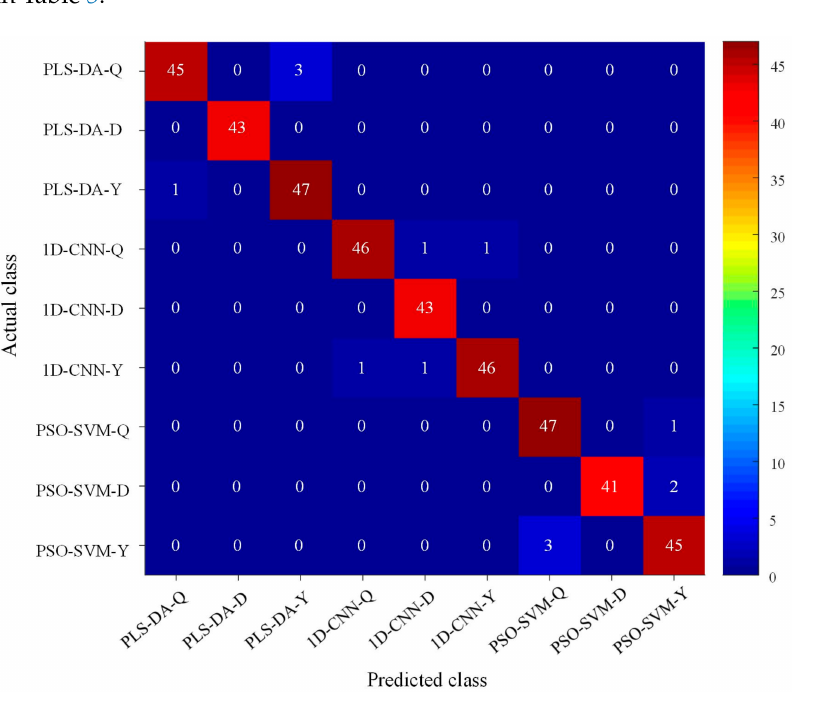
Figure 8. Visualized confusion matrix of three different modeling methods based on their optimal preprocessings, where Q, D, and Y represent “Qianxi”, “Dandong”, and “Yuxi”, respectively.